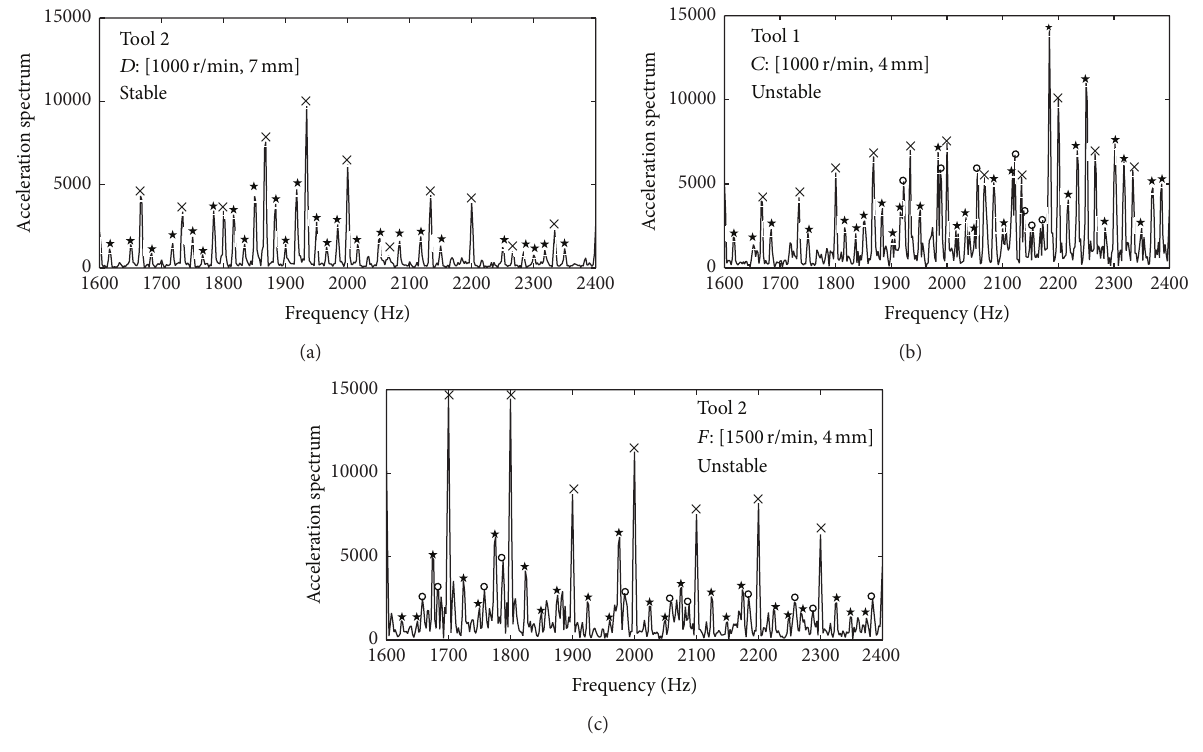
Figure 12: Spectral analysis results (tool